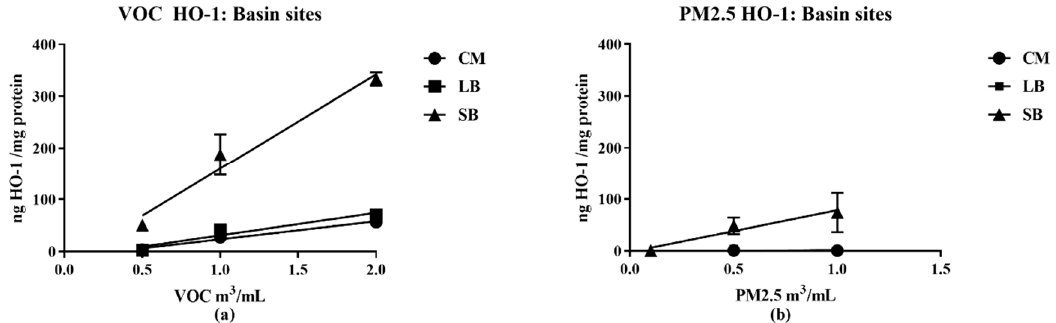
Figure 5. Relative potencies of VOC and PM 2.5 air samples from CM, LB ( a ) and SB ( b ) to increase HO-1 expression in RAW 264.7 macrophages. Cell extracts were measured following exposure to the indicated concentrations of either VOC or its corresponding PM for 16 h. The lines represent the best line fit following linear regression analysis of the results (n = 3 for each data point) with potencies indicated by the slopes (values of the regression analysis are detailed in supplemental data—Table S5).